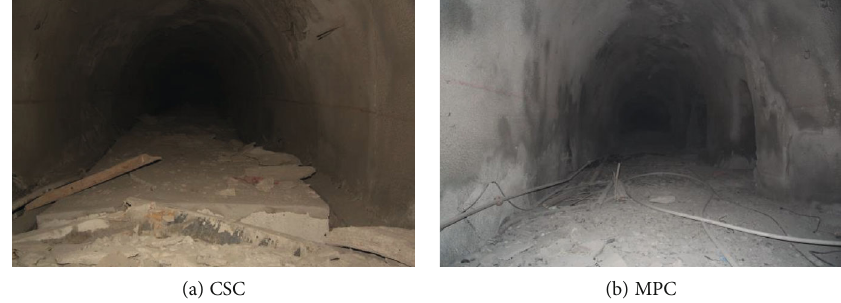
Figure 3: Deformation of the